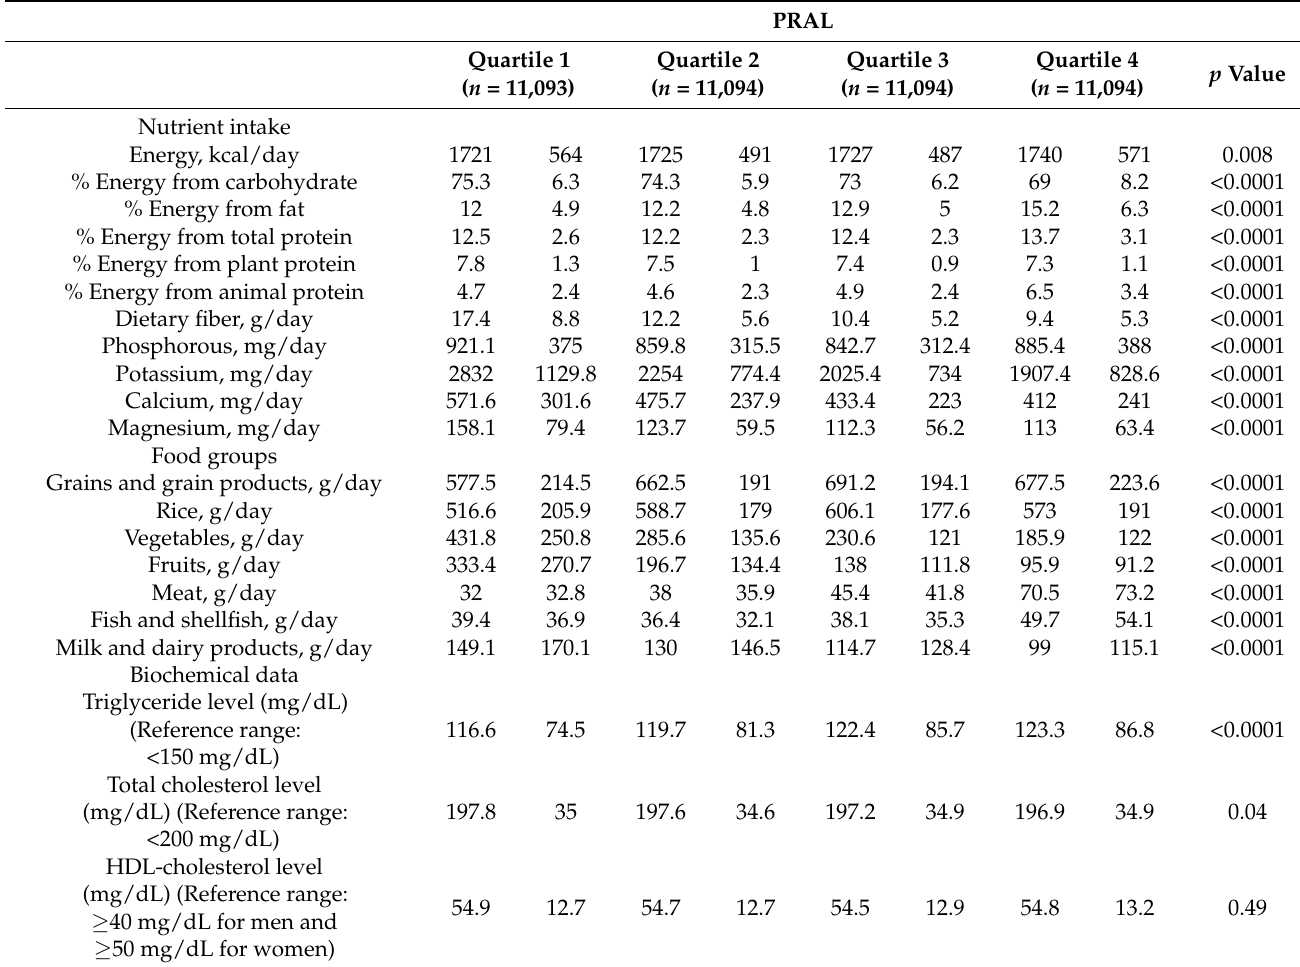
Table 2. Nutrient and food groups intake, and biochemical data according to the quartiles of the PRAL